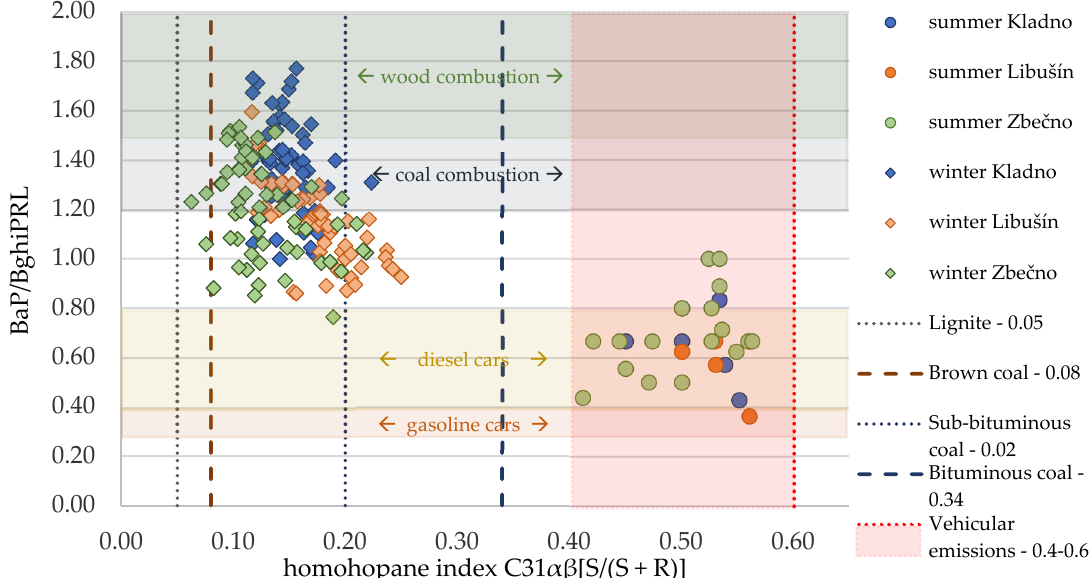
Figure 8. Cross plot for the ratio of BaP/BghiPRL to homohopane index C31 αβ [S/(S + R)]. The different symbols and colors identify measurements performed during the winter (diamonds) and summer (circles) at the three sampling sites (blue—Švermov, orange—Libušín, green—Zbe č no).